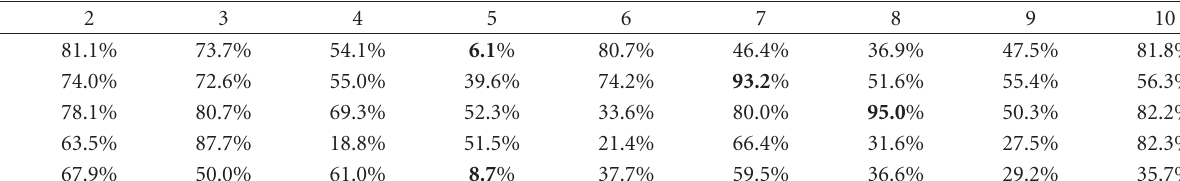
, as given by full-sky (cid:5) ( obs )